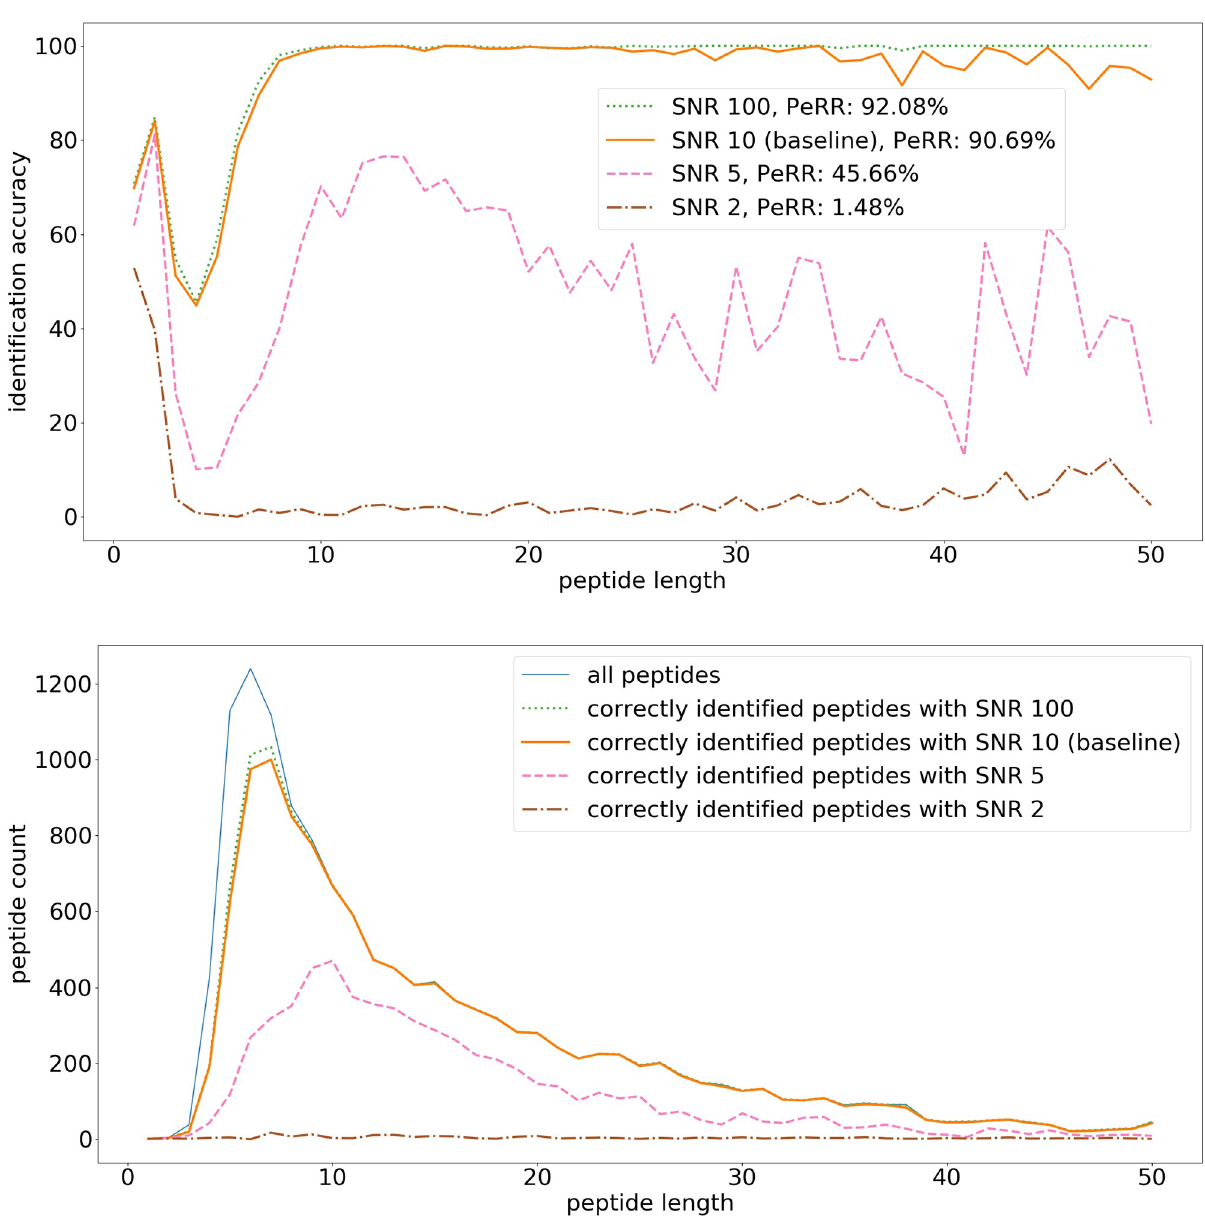
Fig 10. Peptide identification fraction: Initial SNR. (top) The fraction of correctly identified peptides for each peptide length. The legend additionally contains the peptidome recovery rate (PeRR). (bottom) The total peptide count for each peptide length, and the count of correctly identified peptides. The simulation uses the following parameters: 100 ms measurement time per amino acid, pH 2.5, shielding factor exp ð(cid:0) 0 : 2 In these simulations the initial SNR are respectively 100, 10, 5, and 2, the other parameters are the same as in the baseline Fig